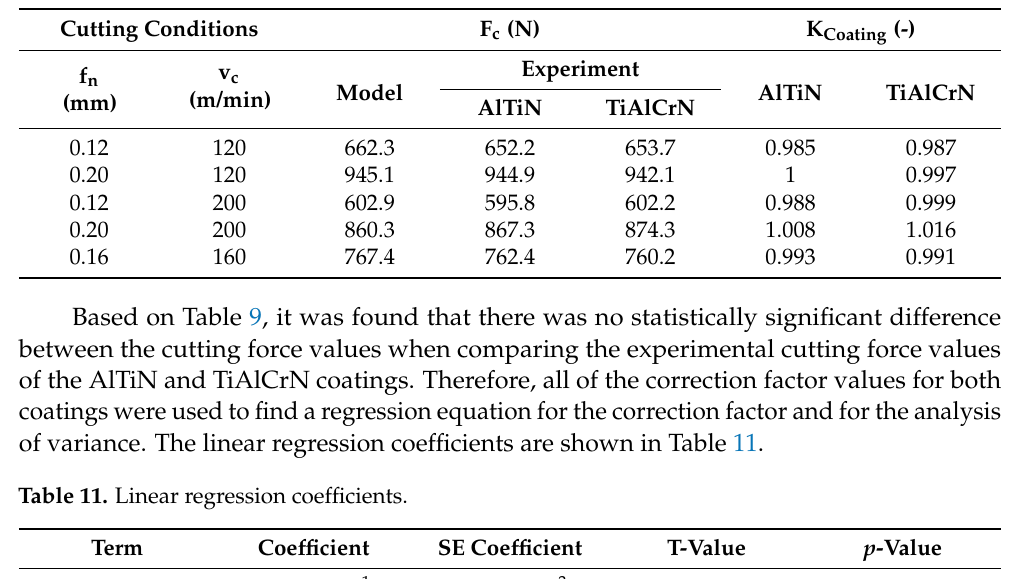
Table 10. Mean cutting force values with standard deviations.